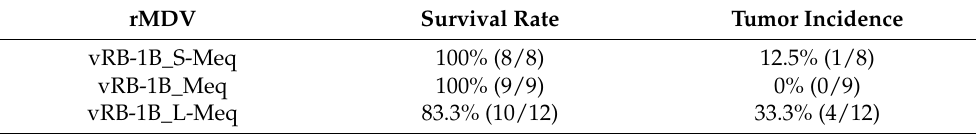
Figure 6. Replication of recombinant MDVs in vaccinated chickens. The chickens were vaccinated and superinfected with vRB-1B_S-Meq, vRB-1B_Meq, or vRB-1B_L-Meq. The viral loads in whole blood were monitored using quantitative polymerase chain reaction with primers specific to the infected cell protein 4 ( ICP4 ) gene of Marek’s disease virus. The growth kinetics among the groups were analyzed using the Kruskal–Wallis test. Table 4. Survival rate and tumor incidence in vaccinated chickens at 56 days post-infection.